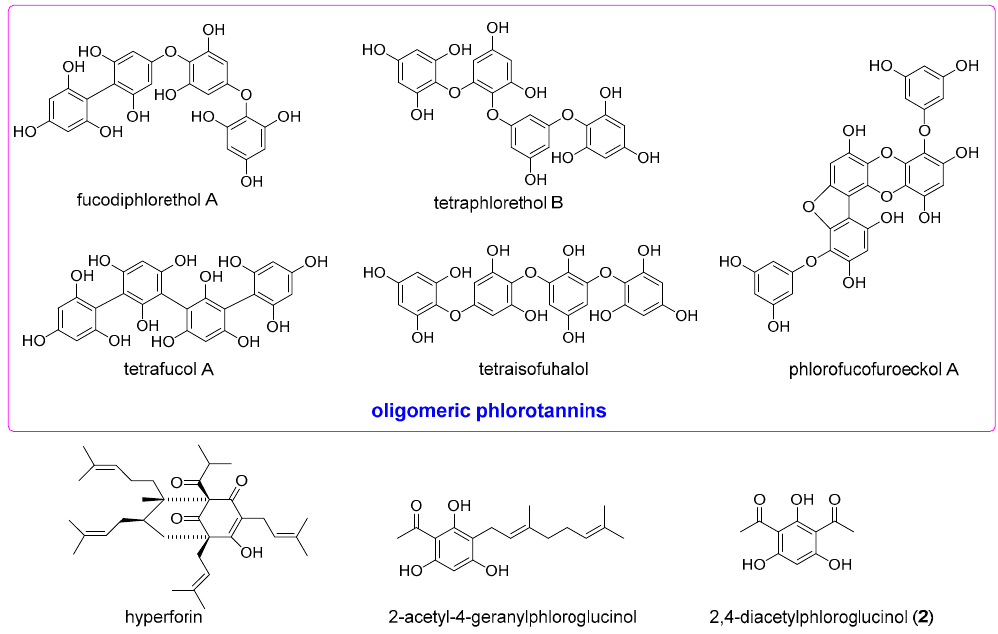
Figure 1. Representative phloroglucinol derivatives with anti-inflammatory activities.